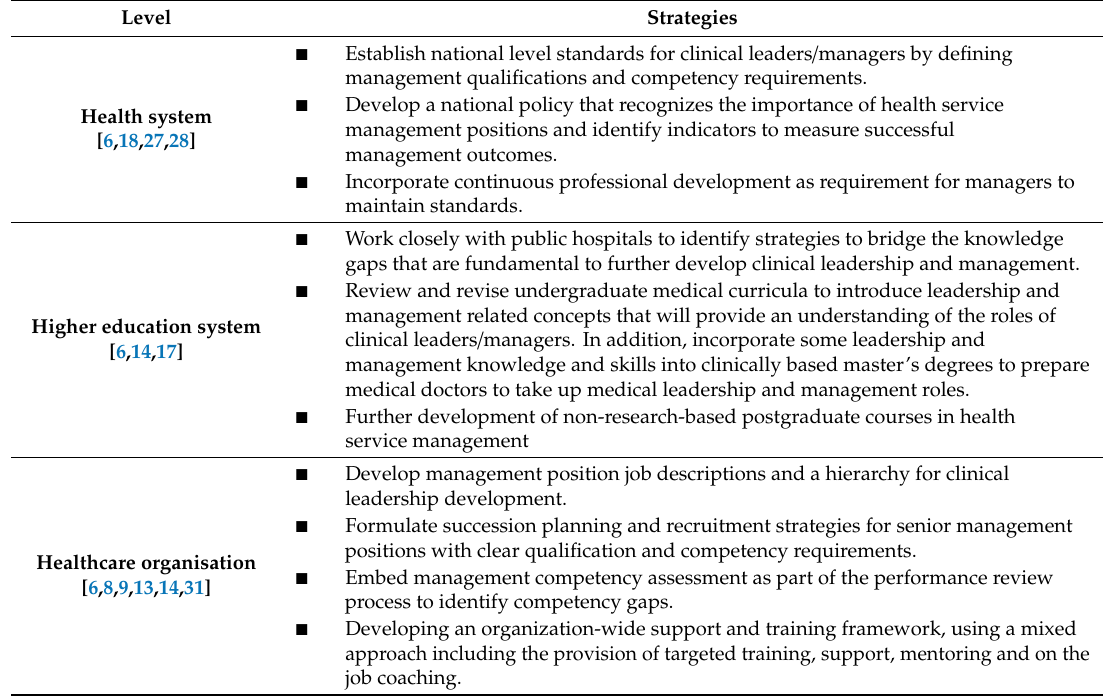
Table 7. Three levels of strategic development for clinical leaders and